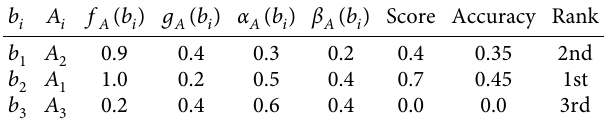
Table 3: LDFNs A i s along with scores, accuracies and rankings on ( C , ⊚ )